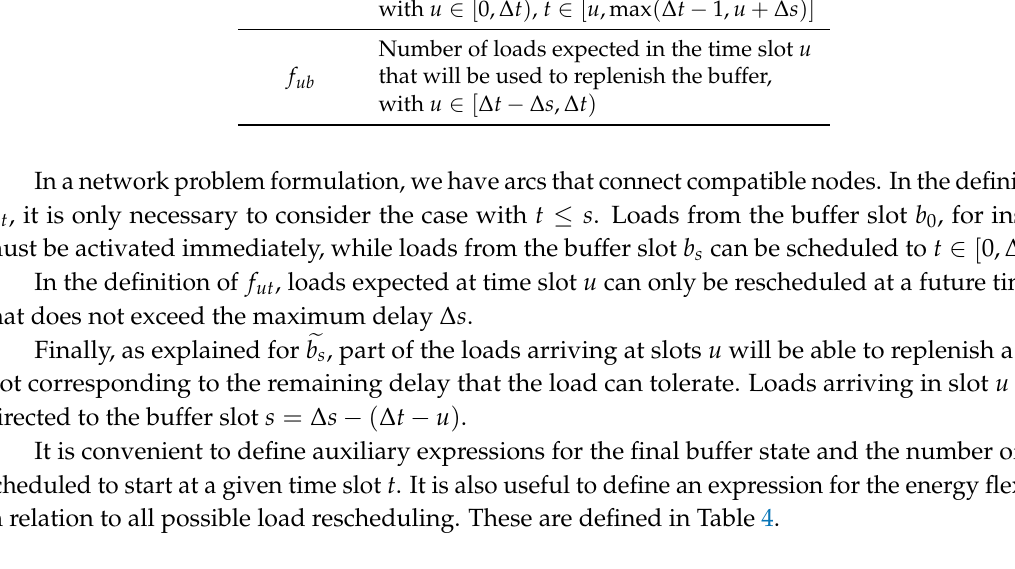
Table 4. Auxiliary